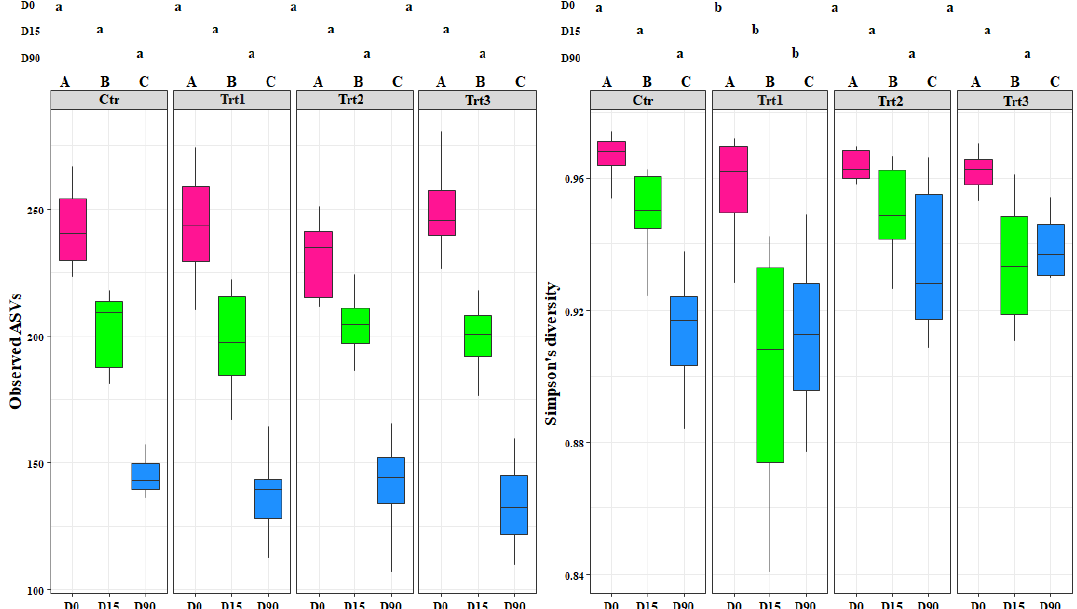
Figure 3. Boxplots of the fungal richness (observed ASVs) and fungal diversity (Simpson’s diversity) at different sampling times (D0: after 12 h; D15: after 15 days; D90: after 90 days). Ctr: bulk soil; Trt1: soil with 10 g of beech wood pellets; Trt2: soil with Trichoderma atroviride SC1 conidial suspension at the rate of 5 × 10 3 conidia · g − 1 of soil; Trt3: soil with 10 g of T. atroviride SC1 coated beech pellets (5 × 10 5 conidia · g − 1 of beech wood pellets). Letters indicate significant differences according to the emmeans package ( α = 0.05) between treatments at each sampling point (lower case letters) or for the same treatment over time (upper case letters). Data of the two experiments E1 and E2 were pooled. Unsupervised non-metric multidimensional scaling (NMDS) ordinations applied on Bray–Curtis dissimilarities showed that the dissimilarities observed among the bacterial samples were grouped (Figure 4) according to the factors, time and treatment, while it pooled the fungal communities only according to the factor, time (Figure 4). In fact, the permutational multivariate analyses of variance (PERMANOVA) on Bray–Curtis dissim- ilarities revealed that time was responsible for the biggest portion of the variation in mi- crobiome beta-diversity. The bacterial community differed very significantly according to the factor time ( F = 144.95, R2 = 0.56, p < 0.001) and treatment ( F = 20.38, R2 = 0.11, p < 0.001), as well as their interaction ( F = 11.37, R2 = 0.13, p < 0.001), and less significantly with the factor experiment ( F = 3.47, R2 = 0.006, p = 0.015). The same was observed for the fungal communities, which varied according to time ( F = 21.99, R2 = 0.23, p < 0.001), treat- ment ( F = 8.59, R2 = 0.14, p < 0.001), the interaction between the two factors ( F = 3.35, R2 = 0.10, p = 0.001), and finally the factor experiment ( F = 2.64, R2 = 0.014, p = 0.006). These results indicate a high consistency of the effects of the treatments over time ( T. atroviride SC1 coated and uncoated wood pellets and T. atroviride SC1) on soil microbial communi- ties.